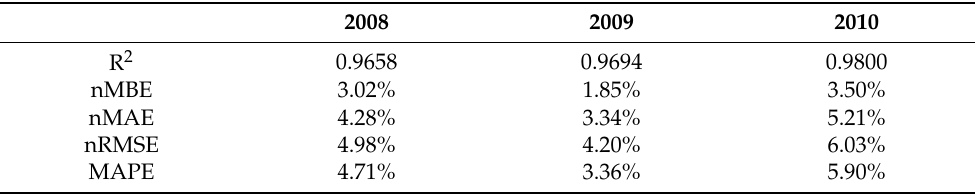
Table 1. Performance of the average daily soil moisture predicted from 100 neural network models that each continuously predicted soil moisture based on their own values.